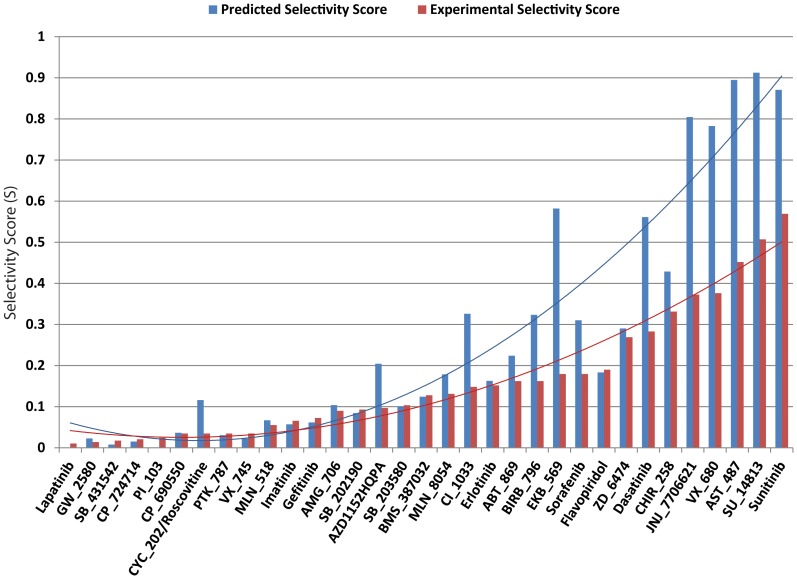
Selectivity scores of 33 kinase inhibitors against 139 kinases.A comparison was conducted using the screening approach proposed in this study (blue bars; PDB IDs from Table S5) and bioassay results [30] (red bars). The calculation of a predicted selectivity score is “S  =  number of kinases docked with score pKd >5.52/total number of kinases tested”, whereas the experimental selectivity scores is “S  =  number of kinases found to bind with Kd <3 µM/number of kinases tested”. A compound with a lower selectivity score indicates that it actively interacts with a small number of target proteins, implying a lower potential for off-target effects. Trendlines are the 2nd order polynomial regression functions. In most cases, screening accurately predicted the actual calculated binding constants; however, in some cases, screening predicted significantly higher binding constants than experimental data revealed, while no significant underestimates were observed.